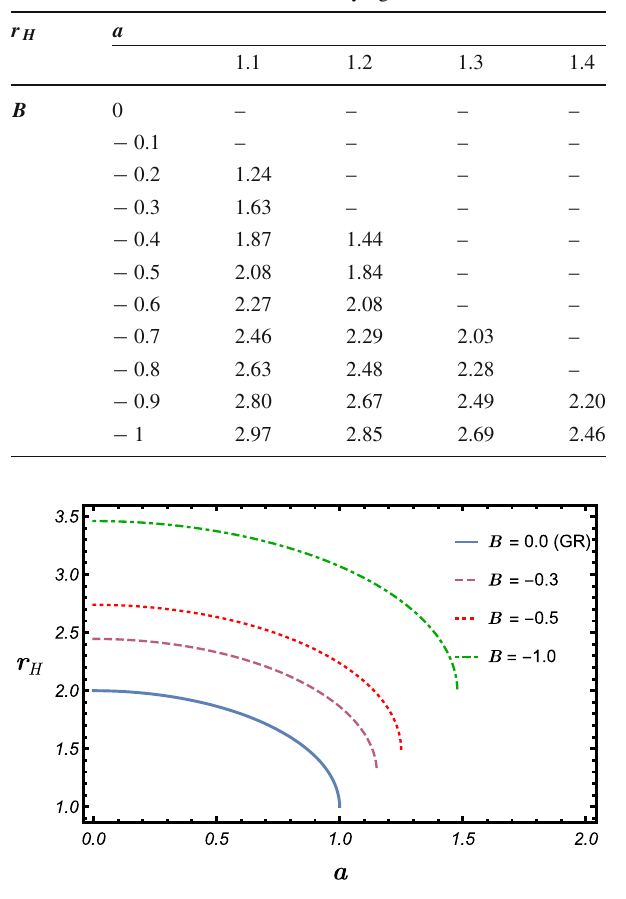
Fig. 1 Variation of event horizon r H as a function of spin of black hole a for different modified gravity parameter B